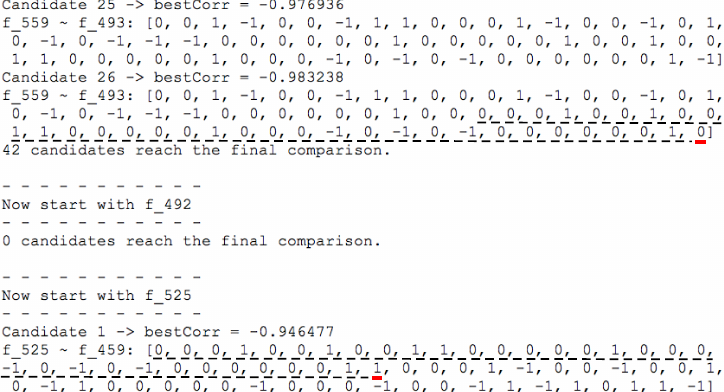
Figure 7: The Error Correction Mechanism in the HIDCPA